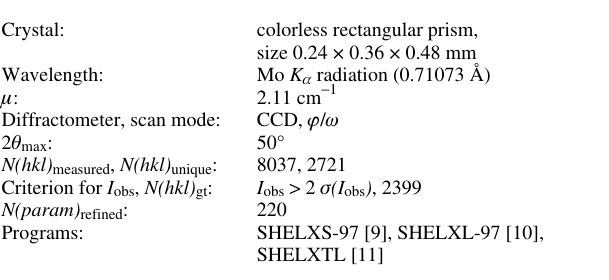
Table 1. Data collection and